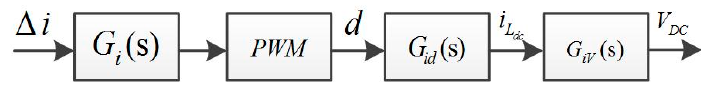
Figure 4. Open-loop control structure of DC/DC converter.